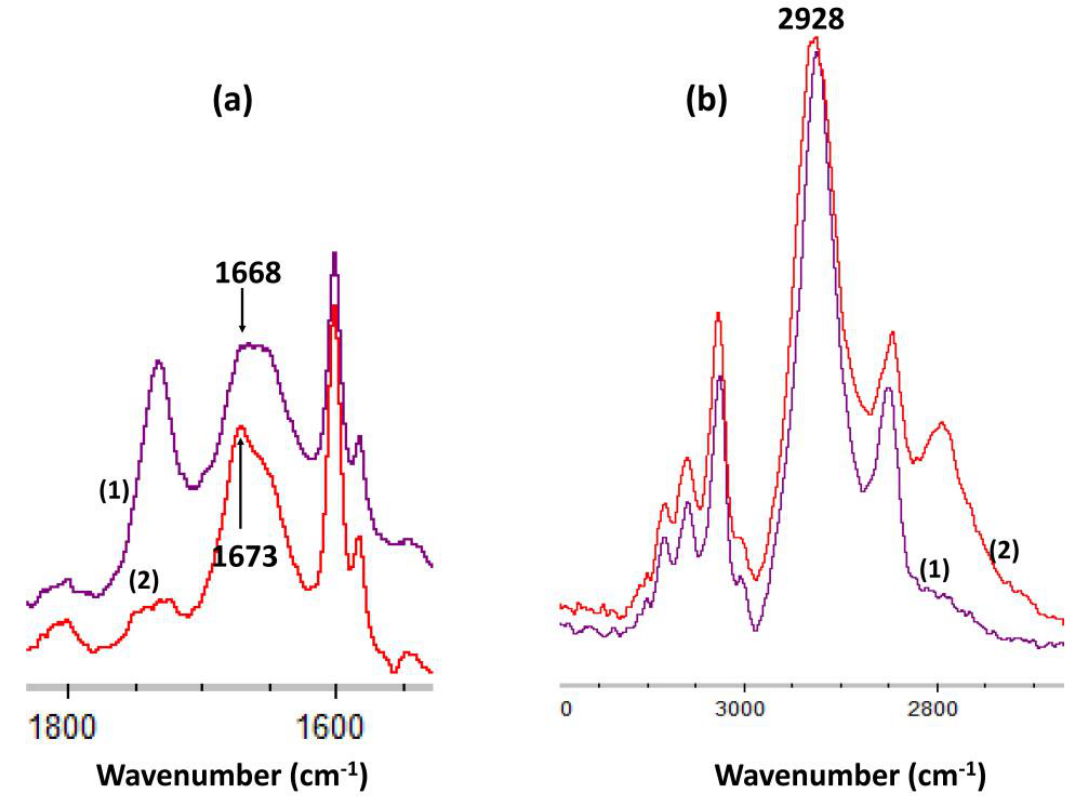
Figure 9 Figure 9. FTIR spectra of ( a ) δ (NH: secondary amines) band in bis-N-MPyC film (1) and in bis-N-MPyC film + Gd 3+ (2) ( b ) ν (CH sp3: -CH2-group) band in bis-N-MPyC film (1) and in bis-N-MPyC film + Gd 3+